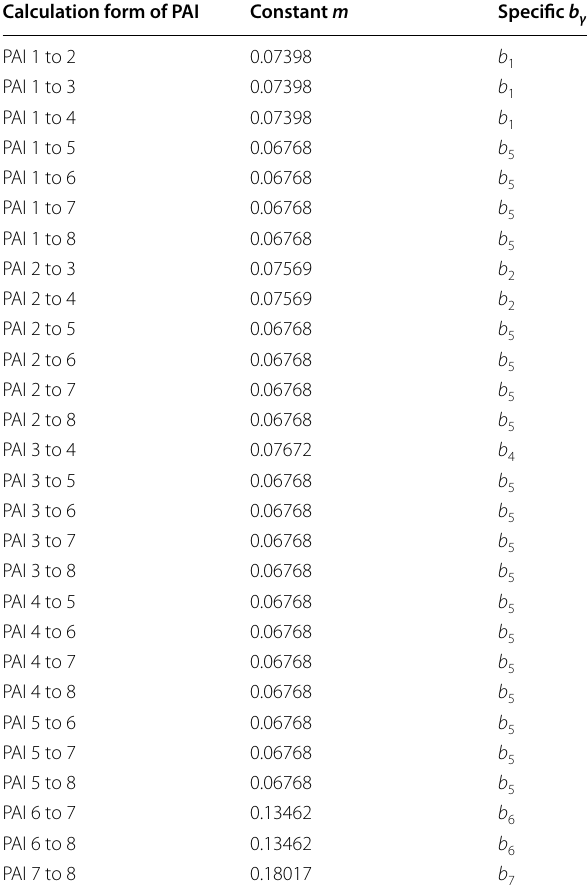
Table 3 Constant m and specific b extracted by different band combinations when the second and third algorithms were implemented on the basis of WorldView-3 Calculation form of